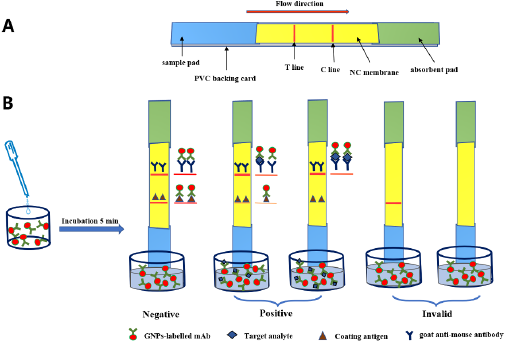
Figure 3. Illustration of the colloidal gold ICA strip: ( A ) structure and ( B ) principle.